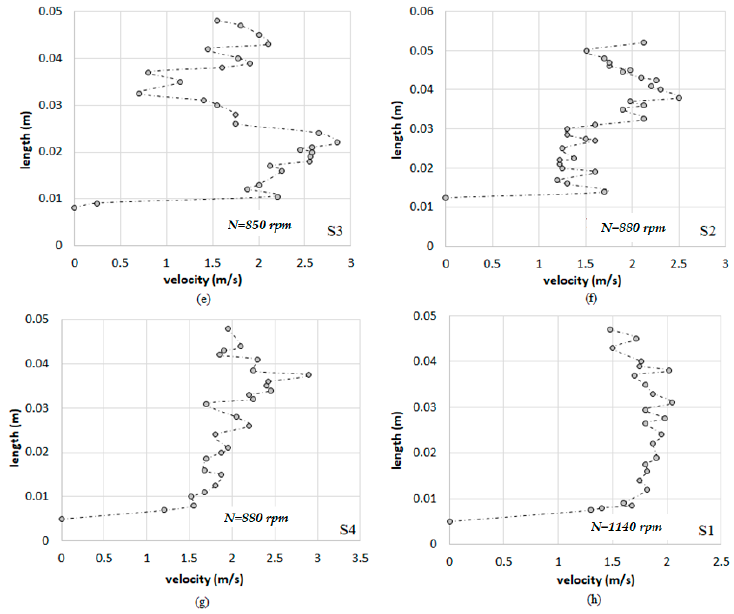
Figure 3. Velocity profiles along the pipe diameter measure with Ultrasonic doppler velocimetry (UDV), expressed as the distance between the UDV probe and faraway pipe wall in the radial direction: ( a ) N = 520 rpm; ( b ) N = 600 rpm; ( c ) N = 680 rpm; ( d ) N = 780 rpm; ( e ) N = 850 rpm; ( f ) N = 880 rpm; ( g ) N = 880 rpm; ( h ) N = 1140 rpm.